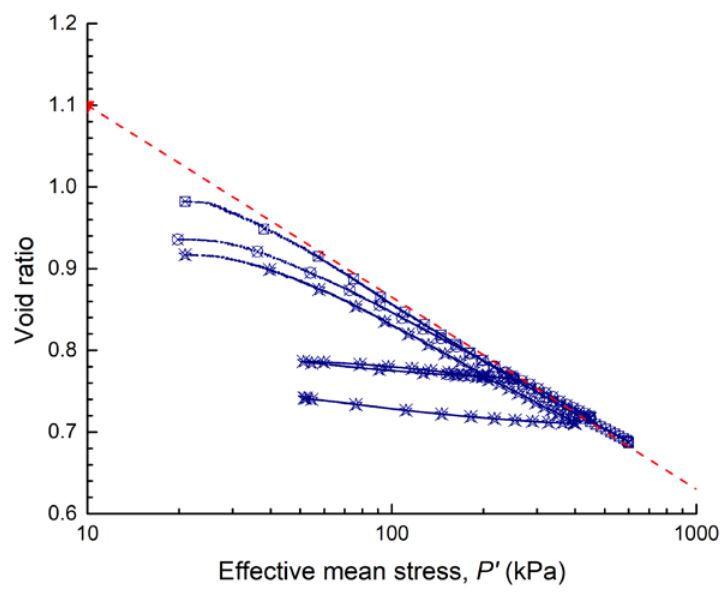
Figure 5. Isotropic compression response of the disturbed soil [30] .